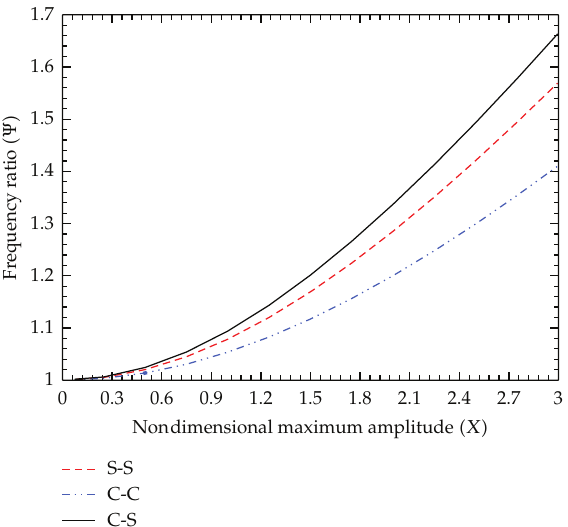
Figure 3: Nondimensional frequency ratio against nondimensional maximum amplitude of SWNTs under various boundary conditions (cid:3) k (cid:8) 10 7 N/m 2 (cid:4)